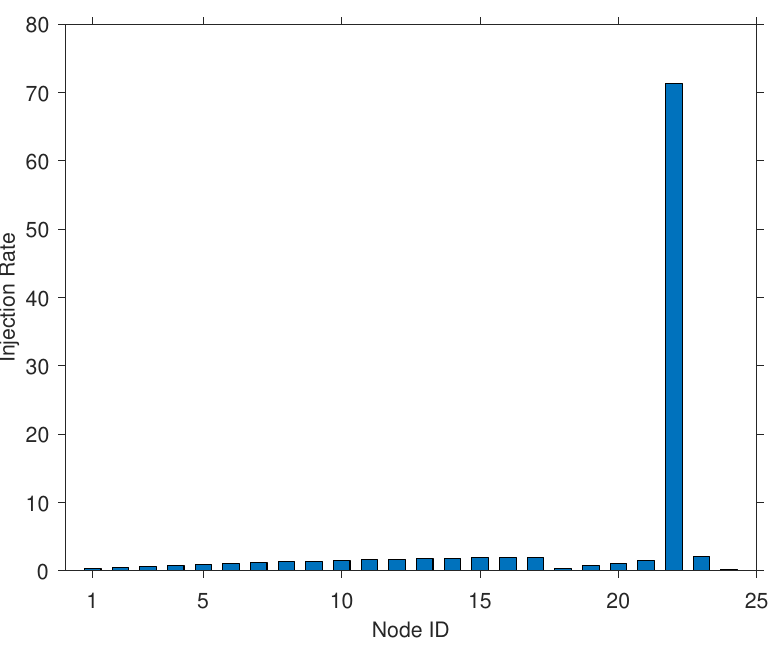
Figure 3. Packets injection rates for the LBIM for a 10 min